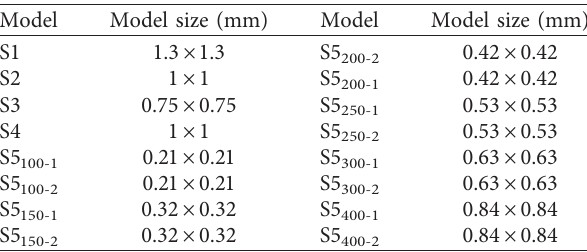
Figure 3: Schematic diagram of solution of pore TC. Table 2: Size of all slices.